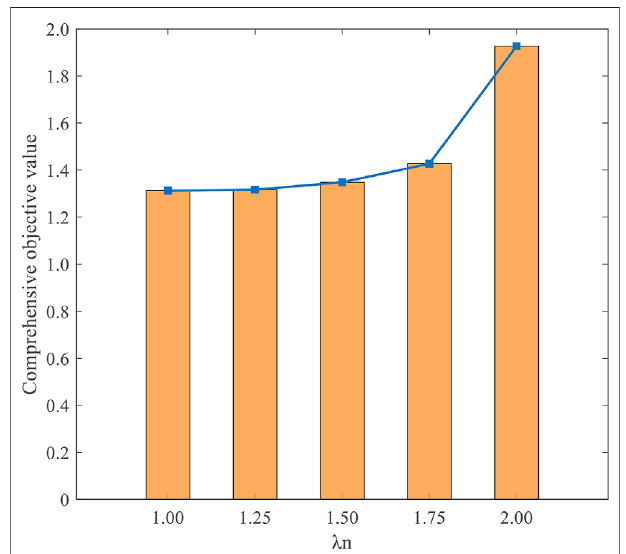
FIGURE 9 | Comprehensive objective value under different EV- guaranteed electricity